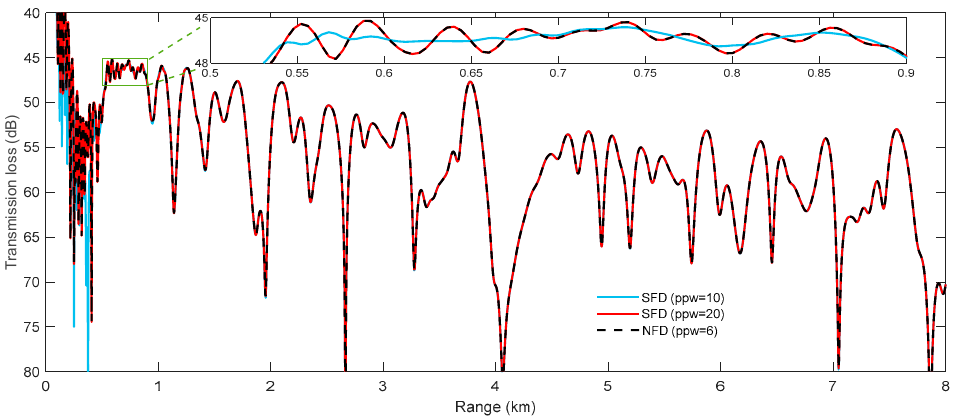
Figure 6. TL curves at the depth of the sound source in the Pekeris waveguide case.